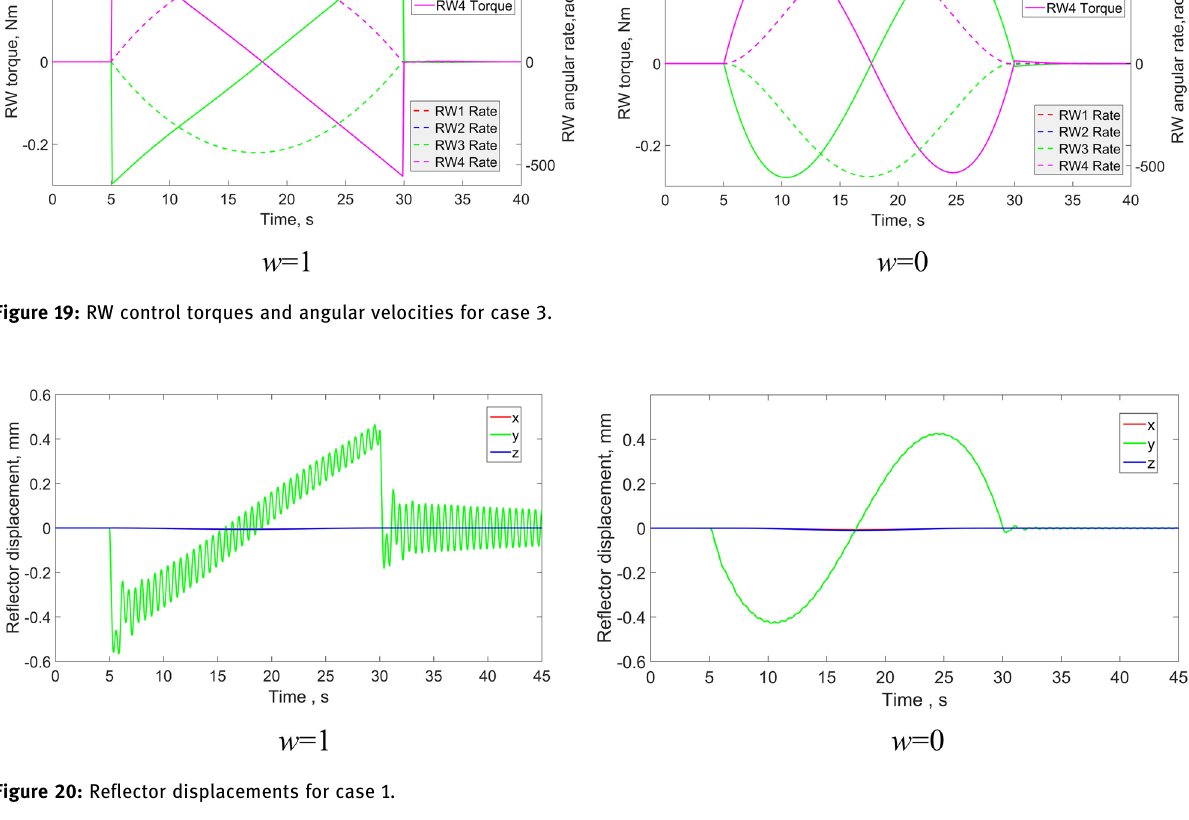
Figure 20: Re fl ector displacements for case 1.